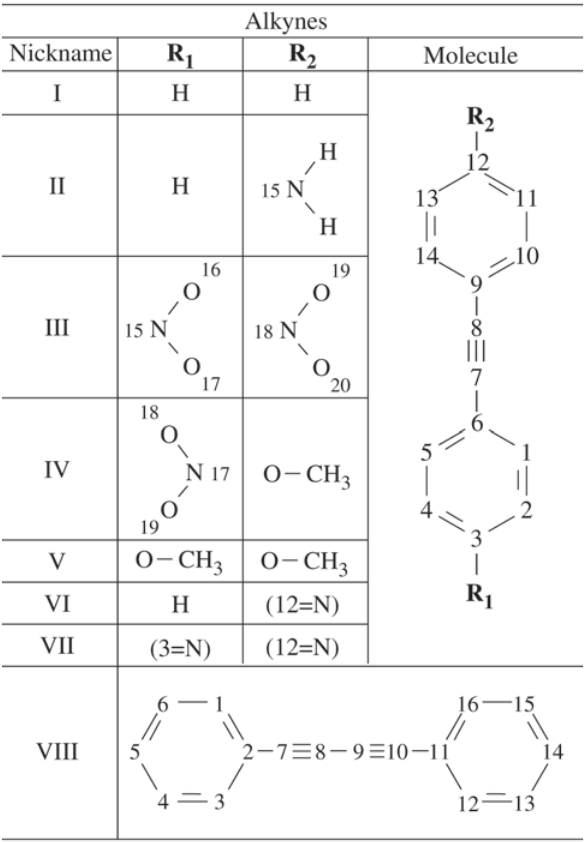
Table 1 . Schematic structures of the alkynes investigated in this work.